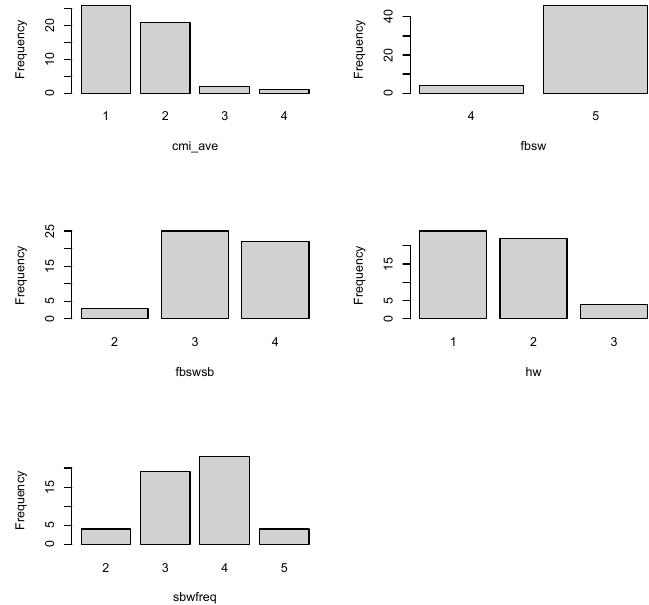
Figure 7. Distributions of the importance rankings of the explanatory variables in 50 classification trees calculated on random samples of the original dataset. Importance was measured by the mean decrease accuracy in the randomForests procedure.